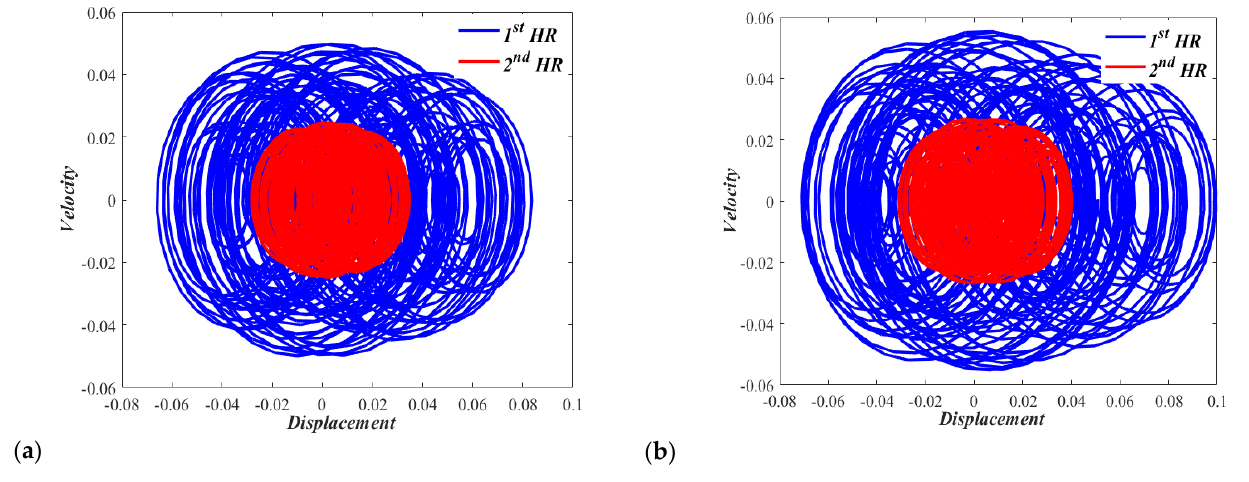
Figure 11. Phase portrait for the nonlinear (CASE II) dual HR excited by, ( a ) p = 165 dB, and ( b ) p = 170 dB.